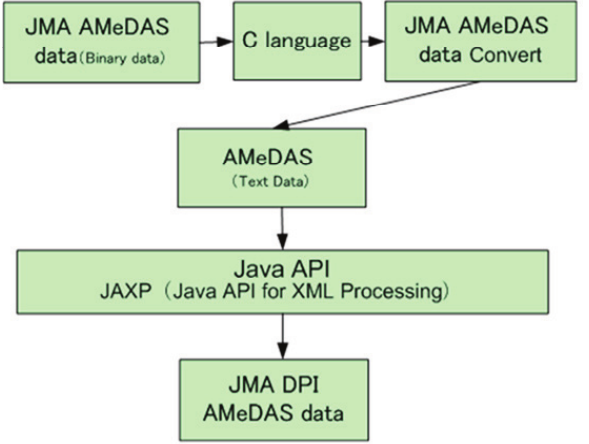
Figure 7. Flow of AMeDAS data format conversion processing